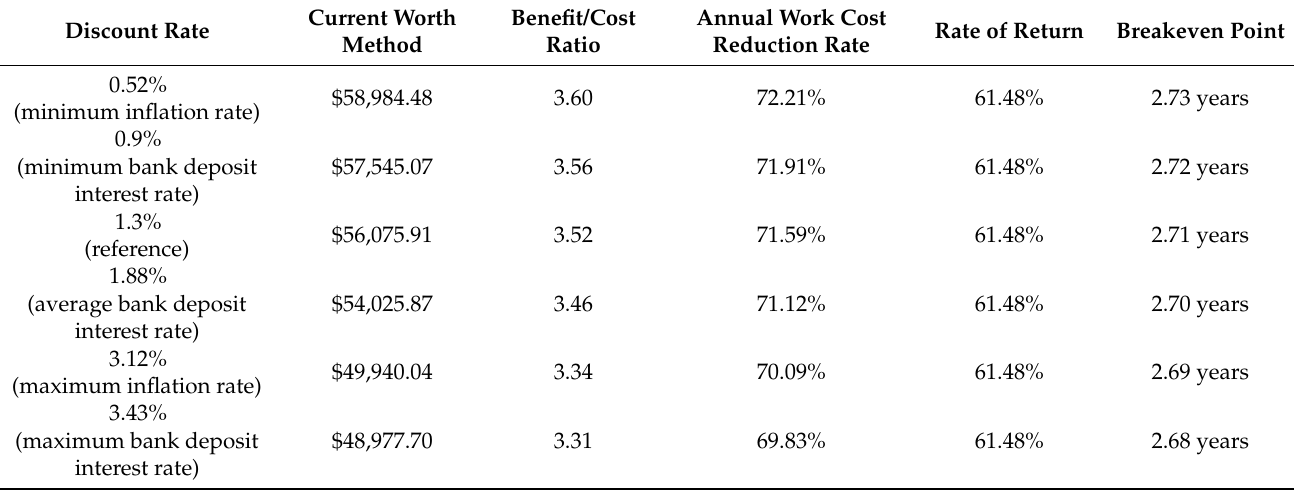
Table A5. Sensitivity analysis results according to the discount